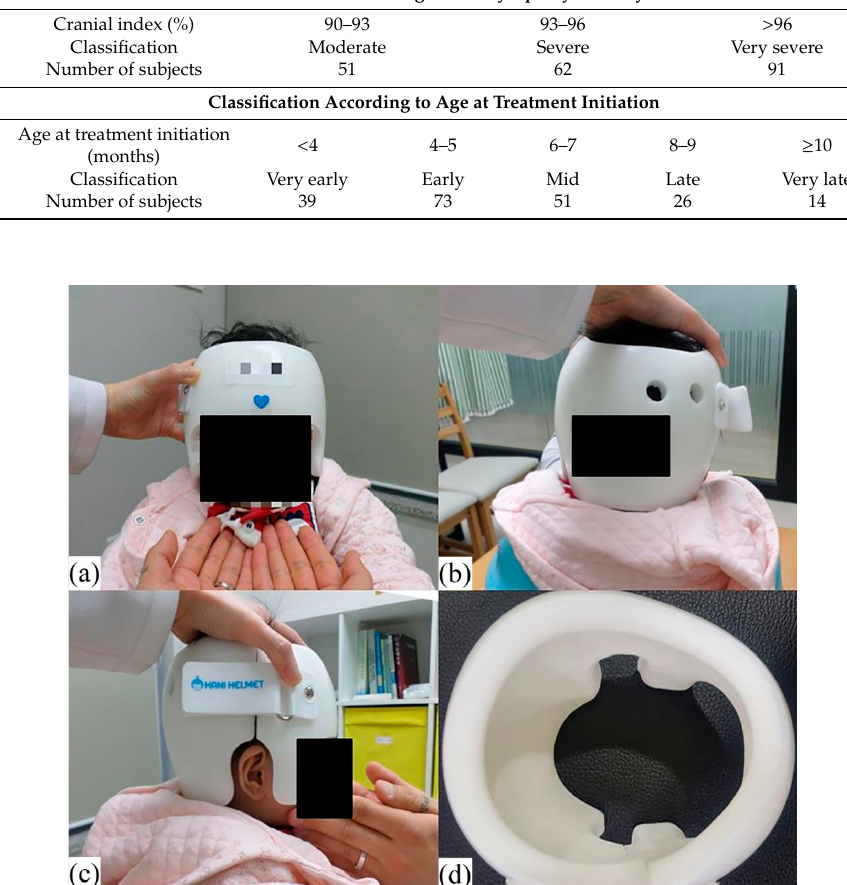
Figure 1. Clinical photograph of an infant wearing a helmet. A helmet, composed of polypropylene (outside) and polyethylene foam (inside), was adjusted to the head of each patient. ( a ) Front view ( b ) Posterior view ( c ) Side view ( d ) Inside view of the helmet.